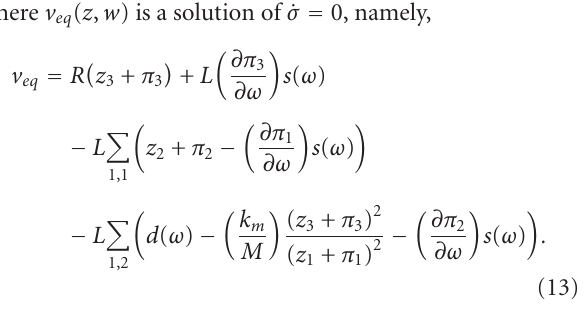
Figure 7: Output tracking signal.